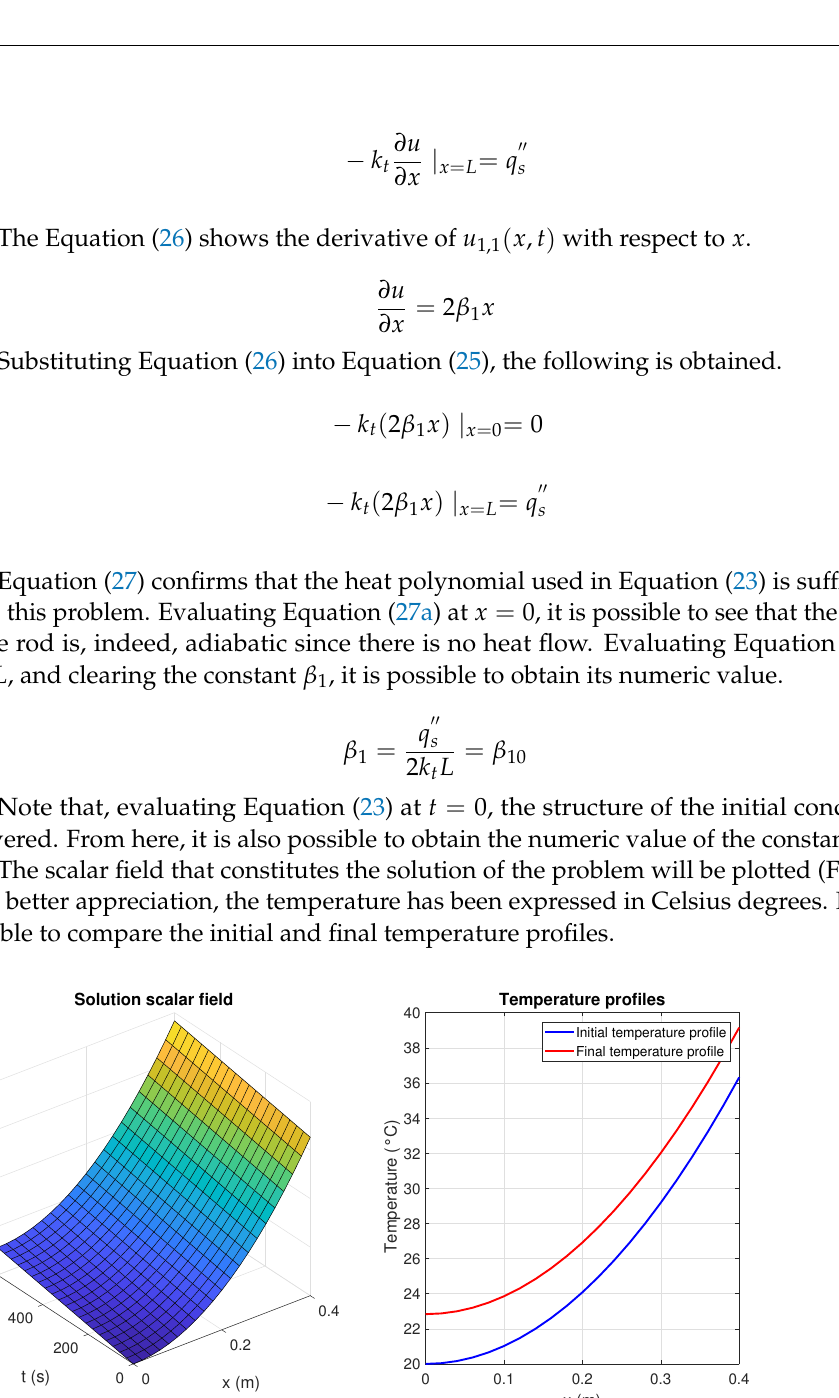
Figure 6. ( left ) Scalar field corresponding to the solution of the problem. ( right ) Initial and final temperature profiles in the iron